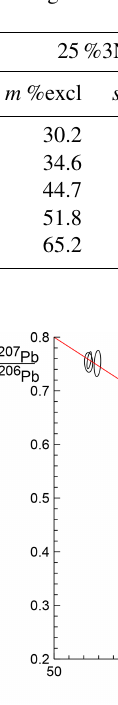
Table 2. Percentage of simulated datasets excluded by the mswd and s bounds given in Table 1 (see text).